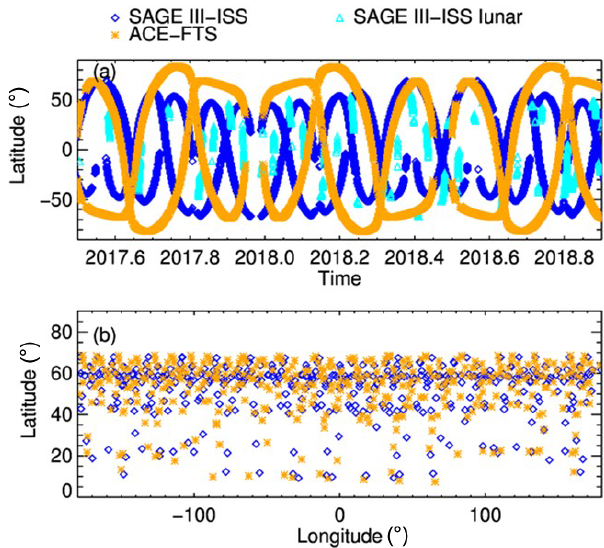
Figure 6. (a) The ACE-FTS and SAGE III-ISS solar and lunar oc- cultation coverage for comparison. (b) The latitude and longitude distribution for coincident events of SAGE III-ISS and ACE-FTS under the criteria of a latitude difference of less than ± 5 ◦ , a lon- gitude difference of less than ± 10 ◦ , and a time difference of less than ± 4h (coincident events could only be found in the Northern